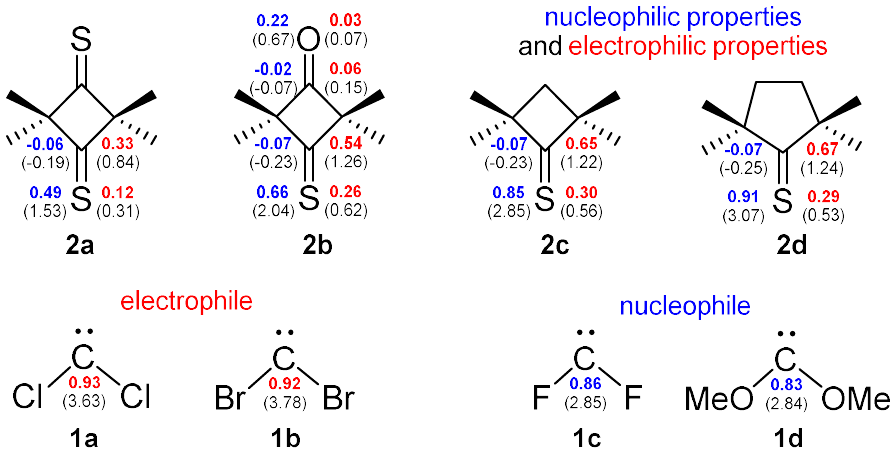
Figure 2. The local electronic properties of carbenes 1a − d and thioketones 2a − d . The nucleophilic P k− given in blue and the electrophilic P k+ given in red; the indexes of local nucleophilicity N k and local electrophilicity ω k given in